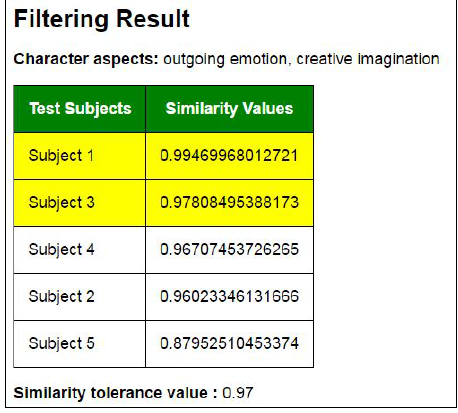
Fig. 3. Filtering result for outgoing emotion and creative imagination aspects